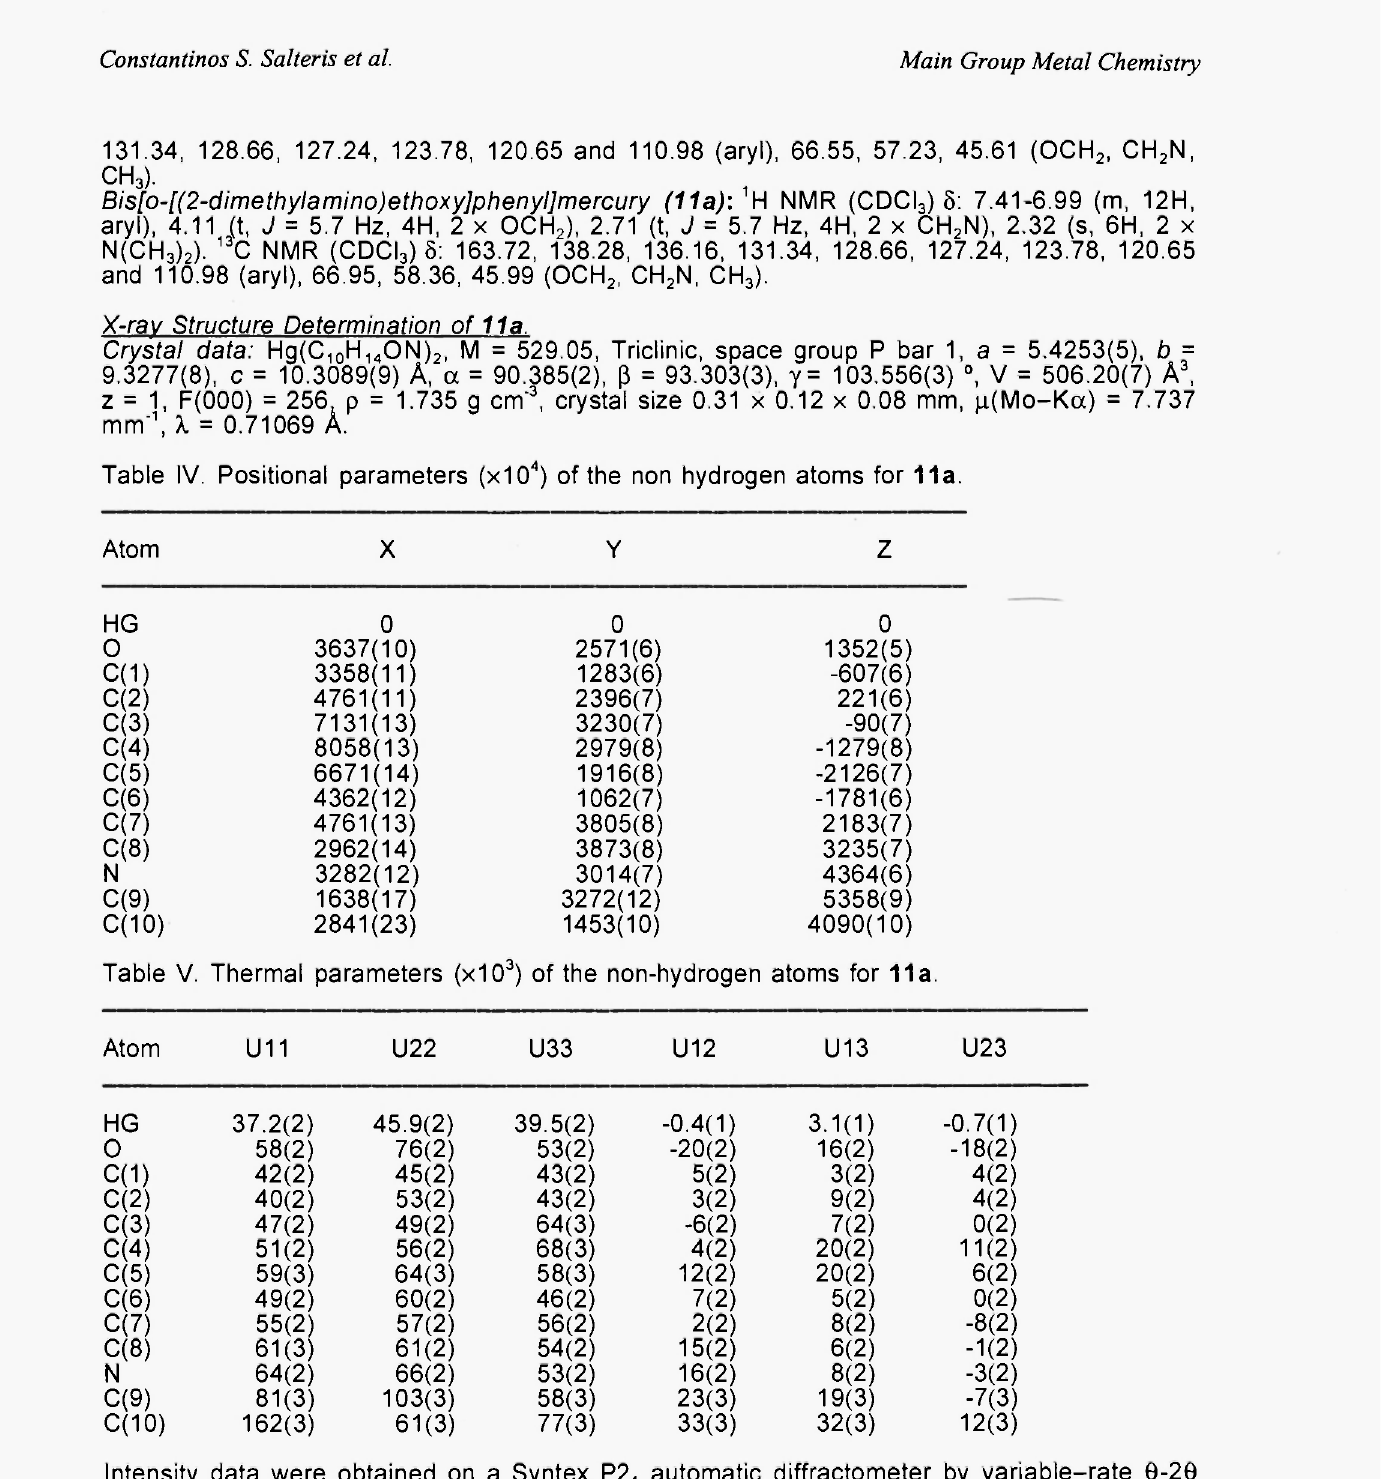
Table IV. Positional parameters (x10 4 ) of the non hydrogen atoms for 11a.